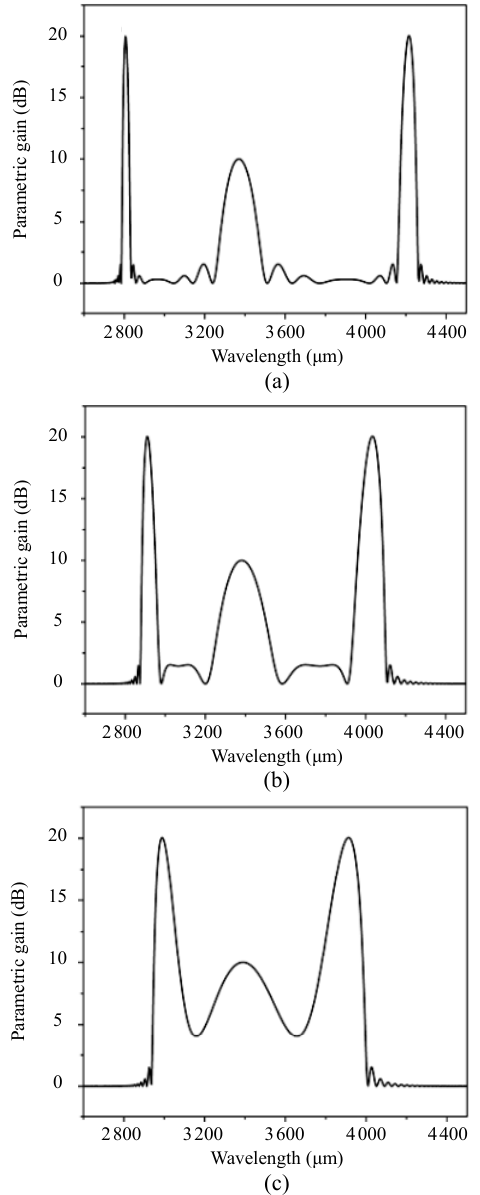
Fig. 4 FWM spectra generated when RI of the filled liquid is 1.36 and the pump wavelengths are (a) 3 370 nm, (b) 3 380 nm, and (c) 3 390 nm,